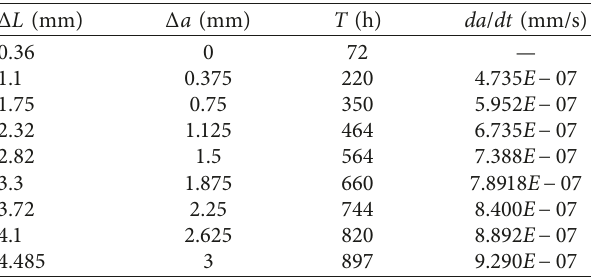
Figure 7: The relationship between crack growth length and load- line displacement. Table 3: The SSRT experimental time,